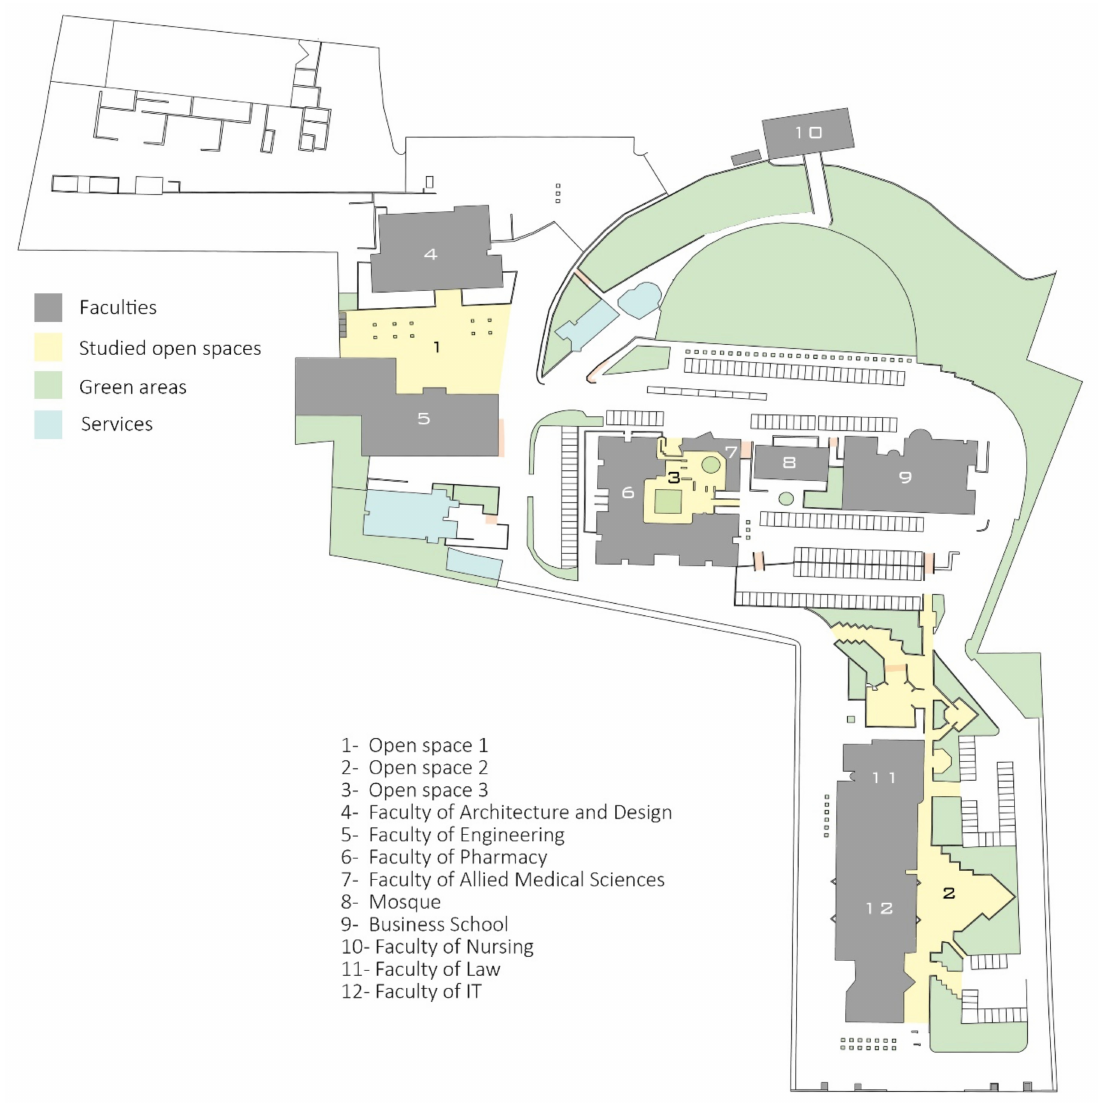
Figure 2. Campus layout and open spaces in Al-Ahliyya Amman University